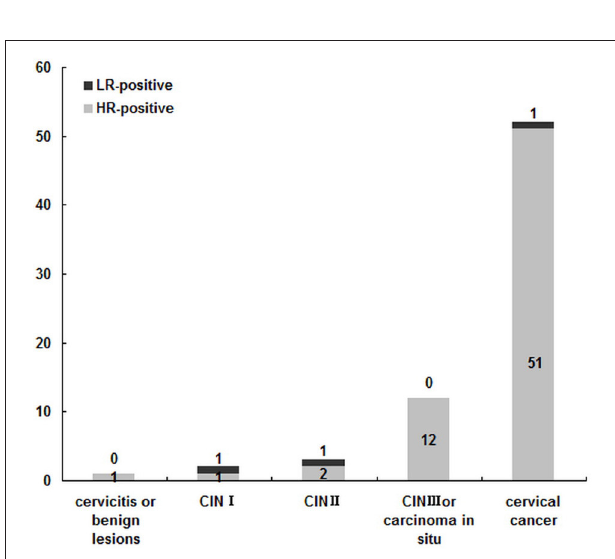
FIGURE 7 | HPV prevalence among 70 HPV positive patients with cervical lesions or carcinoma.